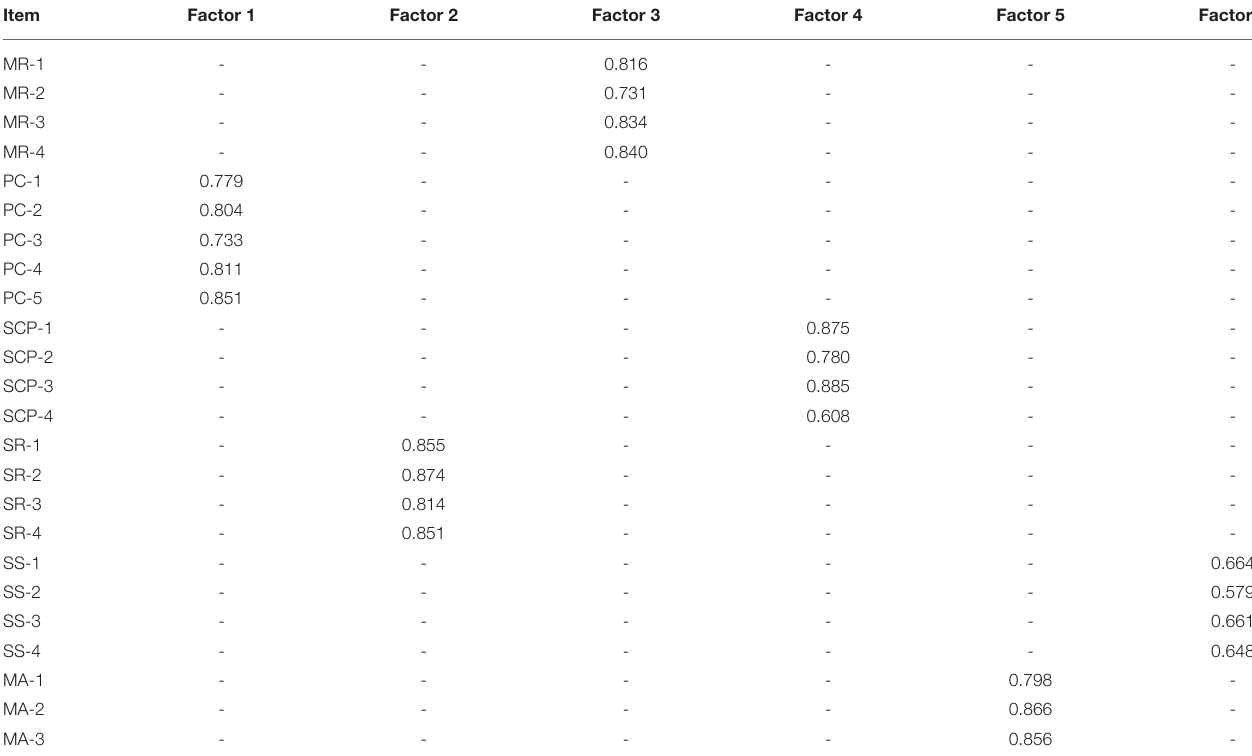
TABLE 5 | Factor loadings of exploratory factor analysis for Chinese version of the B-MSCS.